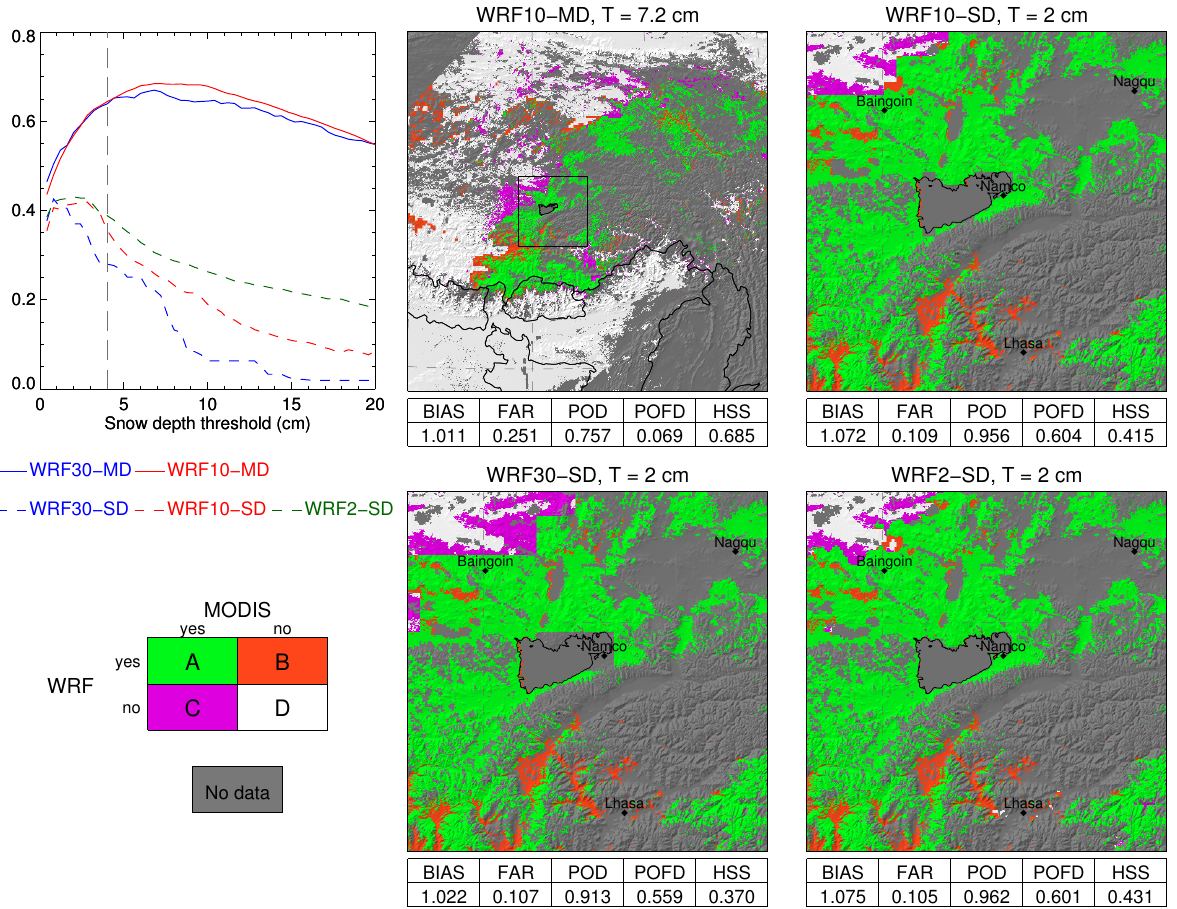
Fig. 6. Left: HSS curves for snow depth predicted by WRF simulations for thresholds between 0.2 and 20cm with respect to snow extent observed by MODIS. Right: spatial patterns of the contingency tables for the snow depth threshold of 7.2cm for WRF10–MD and 2cm WRF10–SD, WRF30–SD and WRF2–SD.